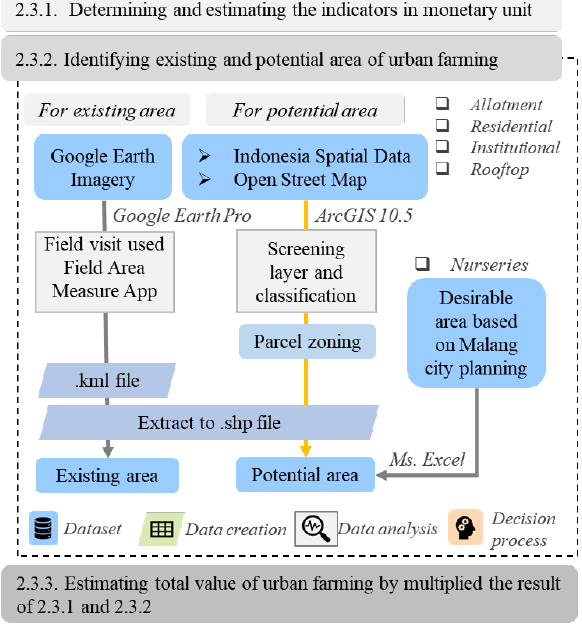
Figure 2. Procedure for the research